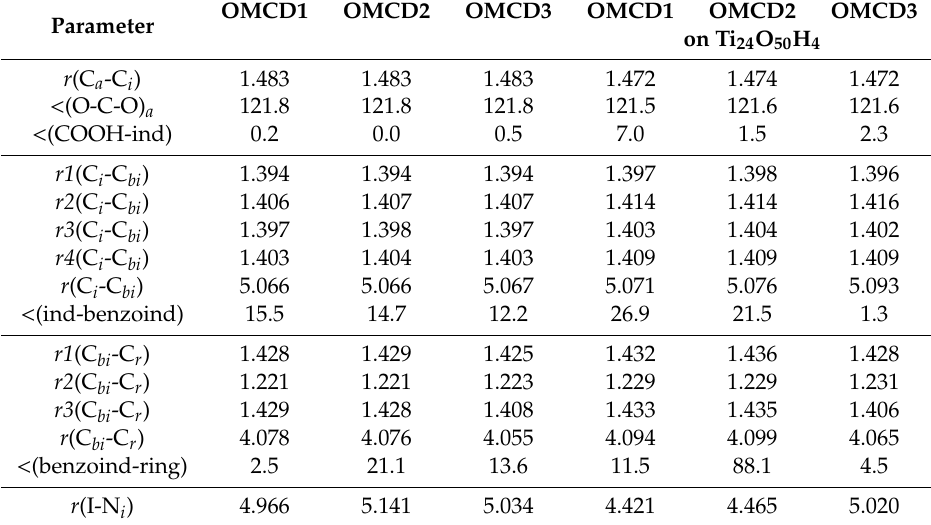
Table 1. The structural parameters of the dyes, obtained after geometry optimization by DFT at B3LYP / DZVP level in ethanol. Geometrical parameters describing the dyes: bond lengths (in Å), the torsion angle of the carboxyl group relative to the indolinium plane, and the dihedral angle defined by the indolinium plane and the plane of the three neighbor Ti atoms on the cluster surface (both in deg).